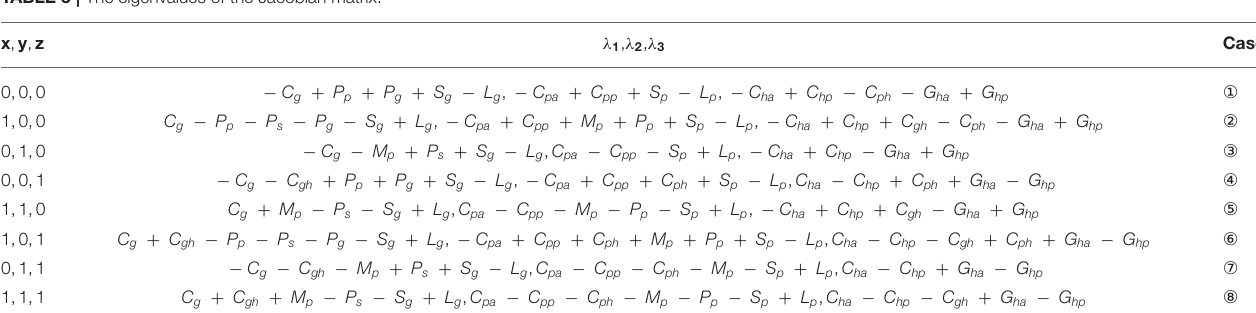
TABLE 3 | The eigenvalues of the Jacobian matrix.